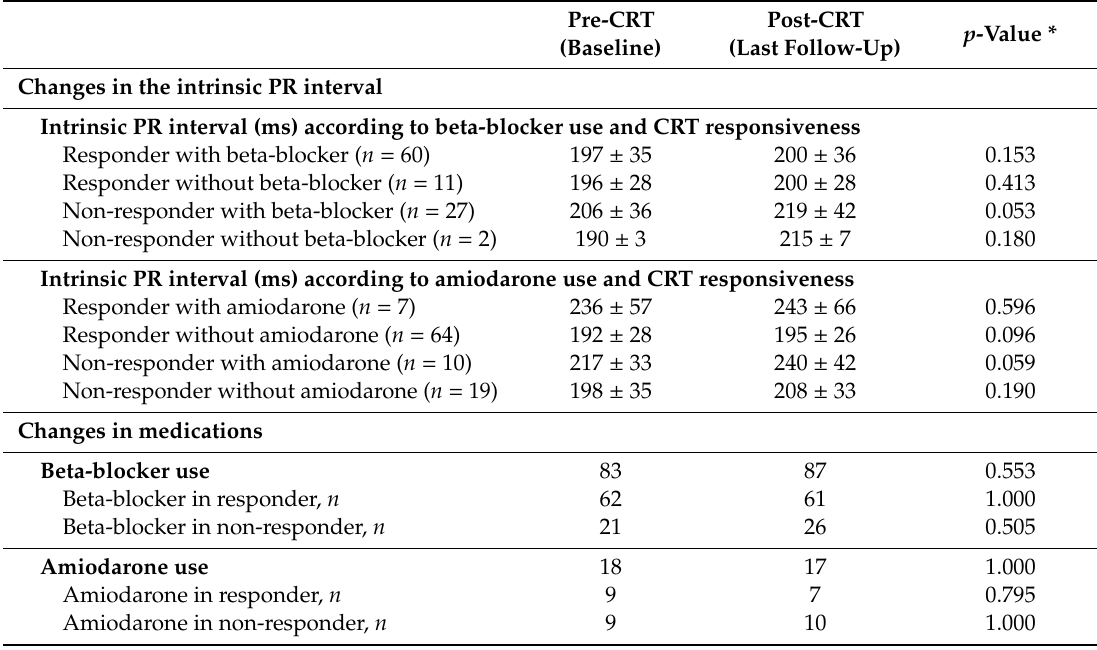
Table 4. Changes in the intrinsic PR interval and medications.